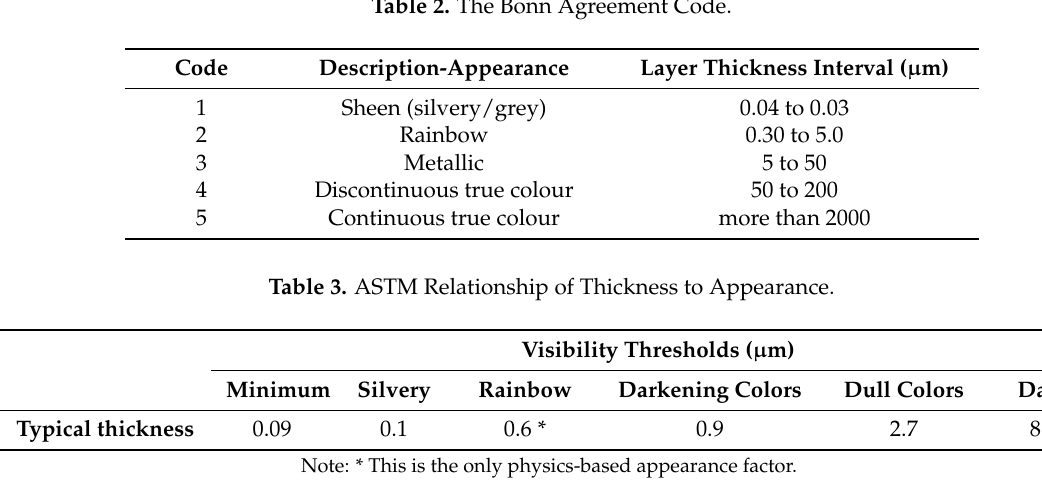
Table 2. The Bonn Agreement Code.